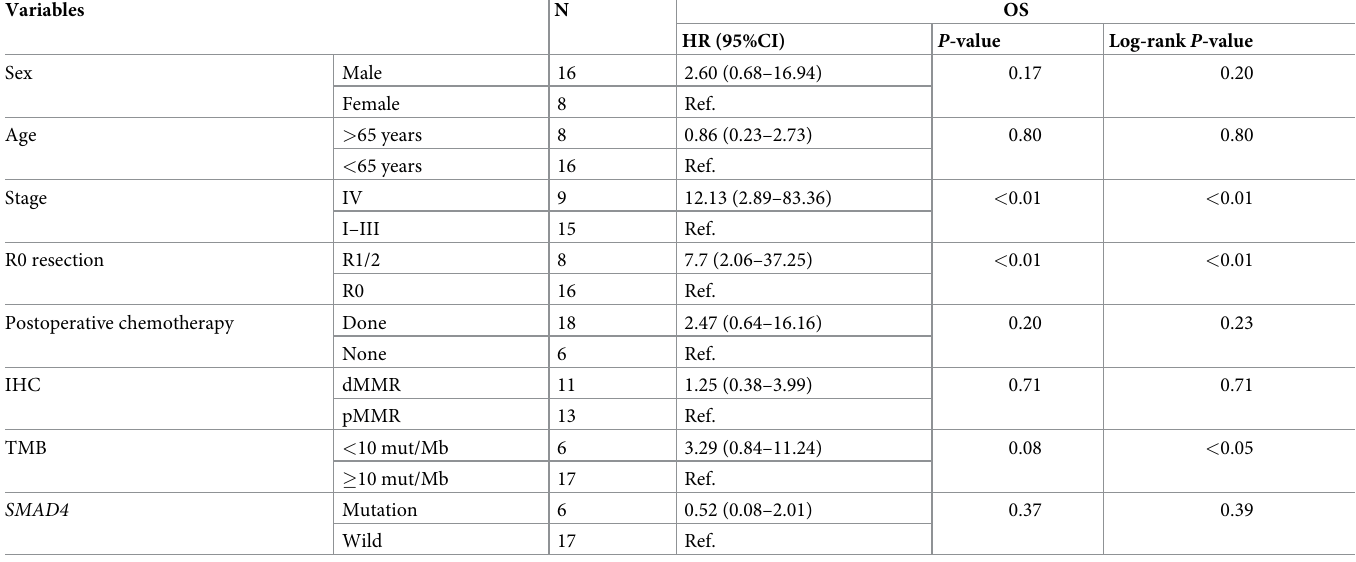
Table 4. Univariate association with overall survival.